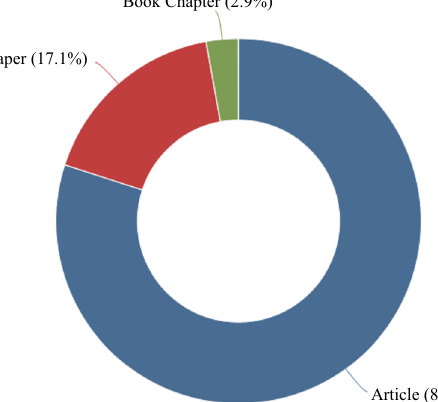
Book Chapter (2.9%)